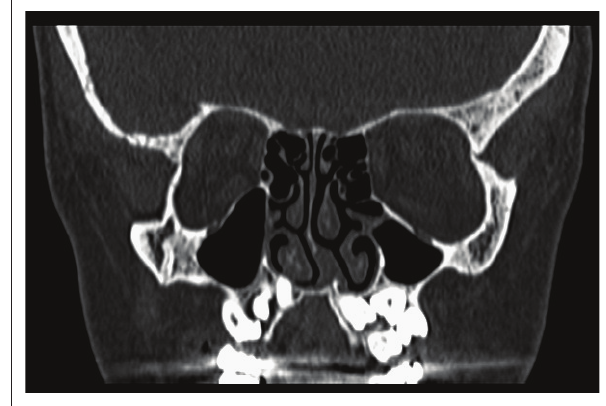
FIGURE 4: Coronal section of computed tomography-paranasal region shows supernumerary unerupted teeth, a deviated nasal septum, hypoplastic maxillary sinuses and a high-arched palate.